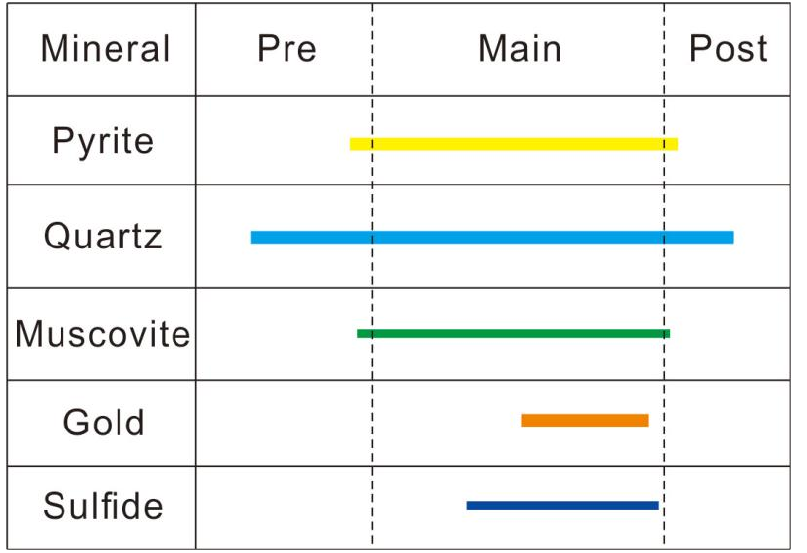
Figure 3. Mineral paragenesis (adapted from [11]). The intensity and scale of mineral occurrence are indicated by the thickness of the line.